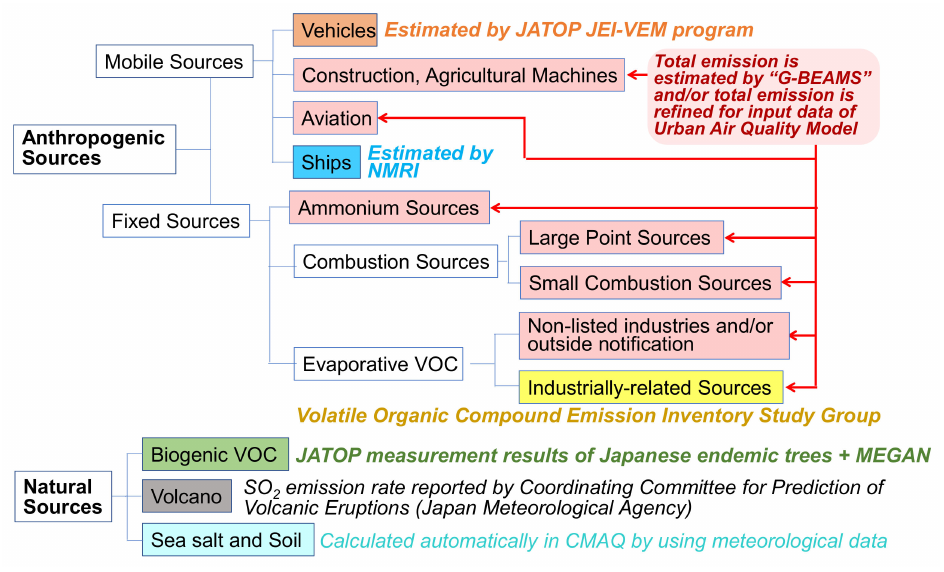
Figure 4. Overall configuration of the emission inventory for Urban Air Quality